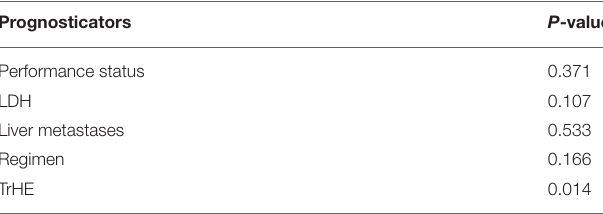
TABLE 4 | Multivariate analyses of prognostic factors for PFS. Prognosticators